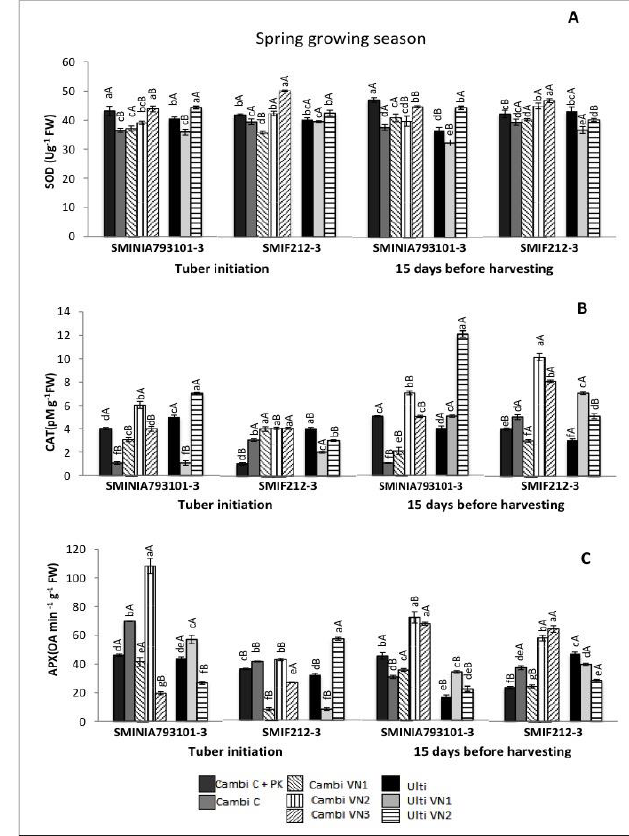
Fig. 5: Effect of increasing Cu levels on leave H 2 O 2 concentration in different development stages (tuber initiation and 15/18 days before harvesting) of different potato genotypes at fall (A) and spring (B) growing seasons. Data represent the mean ± S.D. of six replicates. Different lowercase letters indicate significant differences between Cu levels in the same potato genotype (p < 0.05). Different capital letters indicate significant differences between potato genotypes at the same Cu level (p < 0.05).